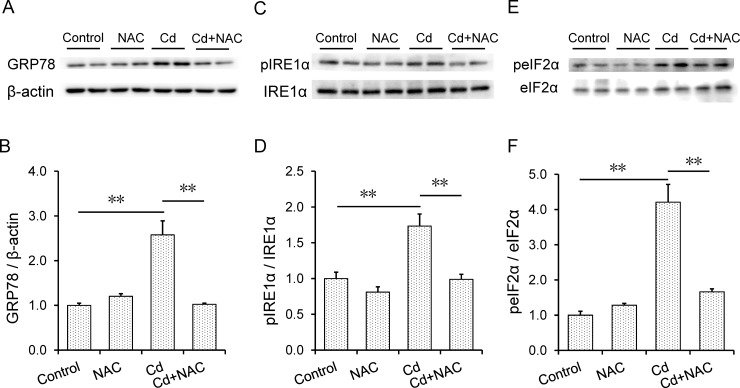
Effects of NAC on Cd-induced placental ER stress.All pregnant mice except controls were i.p. injected with CdCl2 (1.0 mg/kg) daily from GD13 to GD17. In NAC+Cd group, pregnant mice were i.p. injected with NAC (1.0 g/kg) daily from GD12 to GD17, one dose (300 mg/kg) at 8 h before CdCl2 injection, one (400 mg/kg) at 30 min before CdCl2 injection, another (300 mg/kg) at 8 h after CdCl2 injection. Placentas were collected on GD 18. Placental GRP78, pIRE1α and peIF2α were measured using immunoblots. (A) A representative gel for (A) GRP78, (C) pIRE1α and (E) peIF2α was shown. Please see the original bands for GRP78 and beta-actin in S1 and S2 Figs. All experiments were repeated for three times. (B, D, and F) All data were expressed as means ± SEM of six samples from six pregnant mice. **P<0.01.